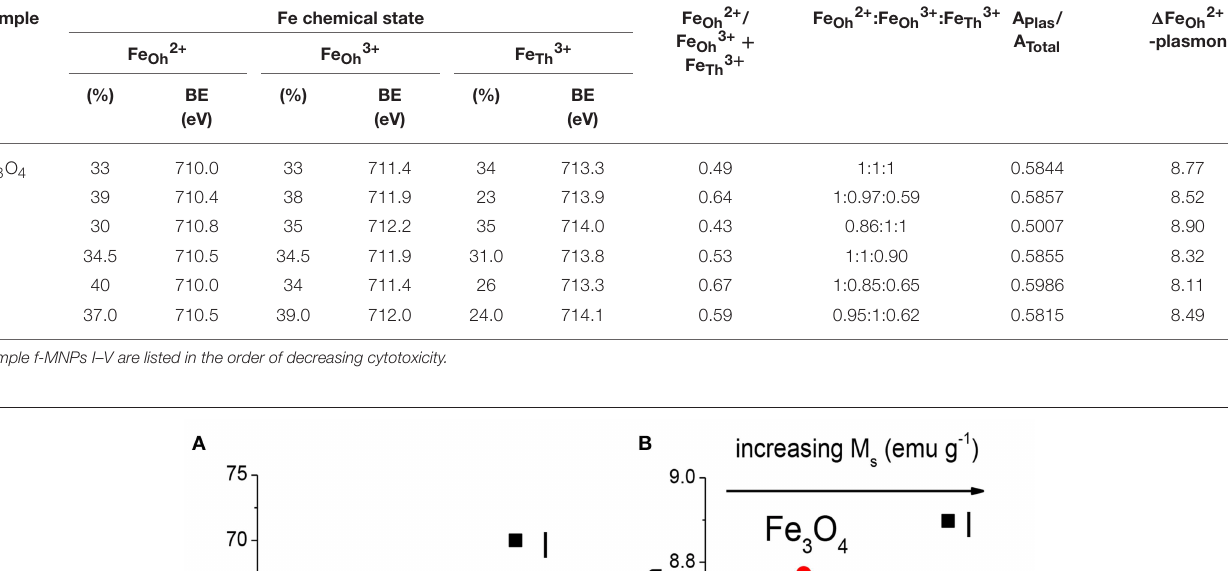
TABLE 1 | The percentage of Fe 2 + / Fe 3 + octahedral (Oh) and Fe 3 + tetrahedral (Th) chemical states including BE values of Fe 2p 3 / 2 components; ratio of separation between Fe 2p 3 / 2 octahedral 2 + component and plasmon loss; ratios of Fe Oh2 + , Fe Oh3 + , and Fe Th3 + components; ratio of plasmon loss to the total area and separation of Fe Oh2 + components from plasmon loss in Fe 2p 3 / 2 spectra recorded from Fe 3 O 4 and Fe 3 O 4 f-MNPs I–V.